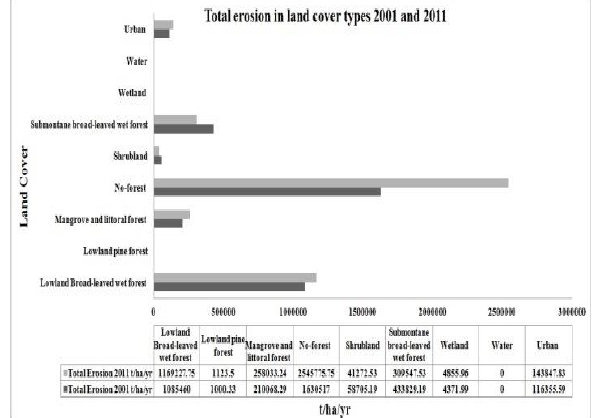
Figure 8. Total erosion in land cover types in 2001 and